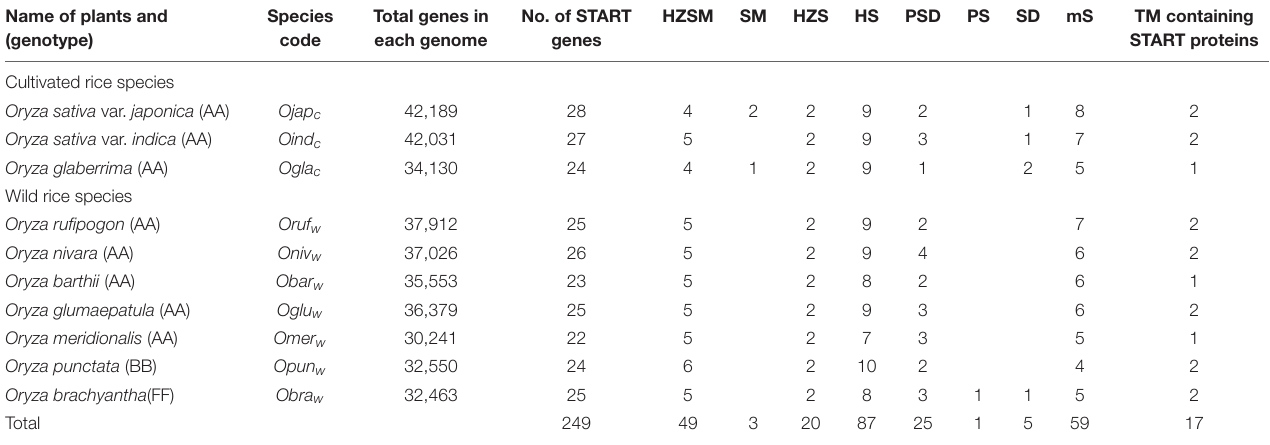
TABLE 1 | Identification and domain structure analysis of START proteins across cultivated and wild rice species. Name of plants and